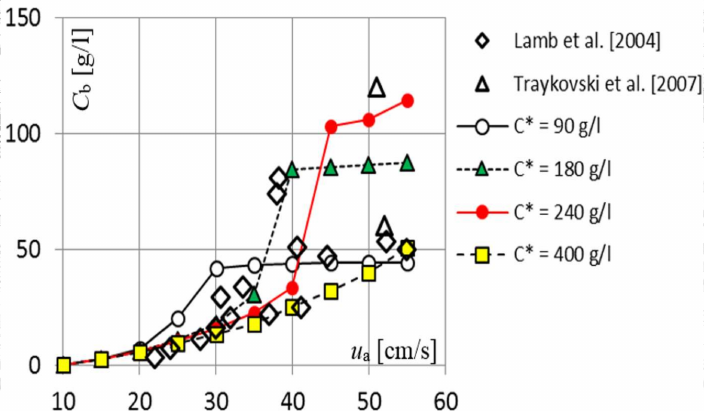
Figure 6. Same as Figure 3, but including model-simulated equilibrium near-bottom suspended sediment concentrations, C b , from 4 sequences of numerical